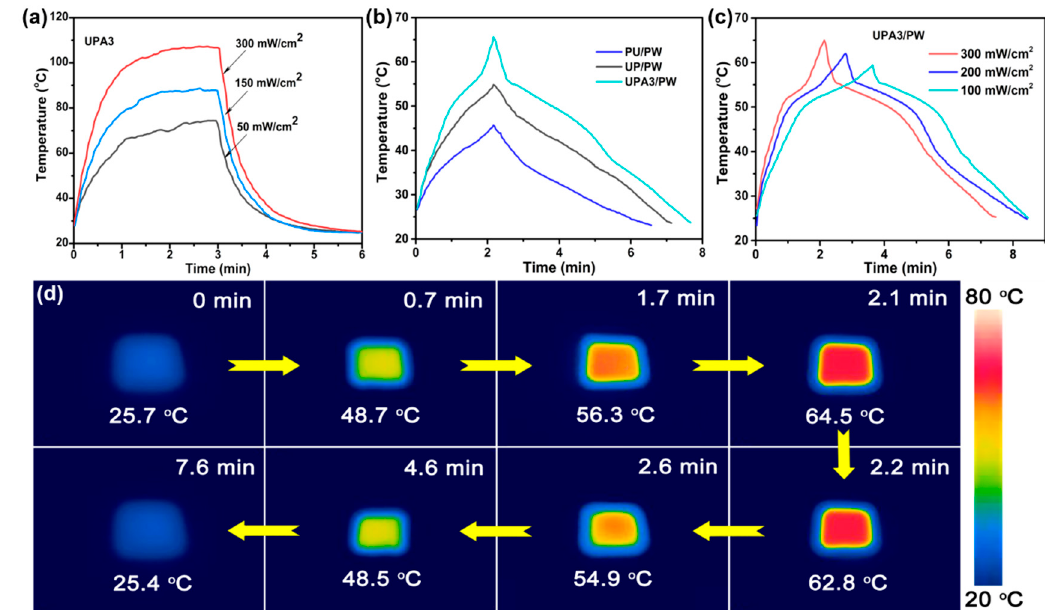
Figure 4. Time–temperature curves of ( a ) UPA3, ( b ) PU/PW, UP/PW and UPA3/PW, and ( c ) UPA3/PW (13 × 13 × 3.0 mm, mass: 142.9 mg) under various solar intensity; ( d ) Infrared thermal images showing the solar–thermal energy conversion, storage and release behavior of the UPA3/PW.